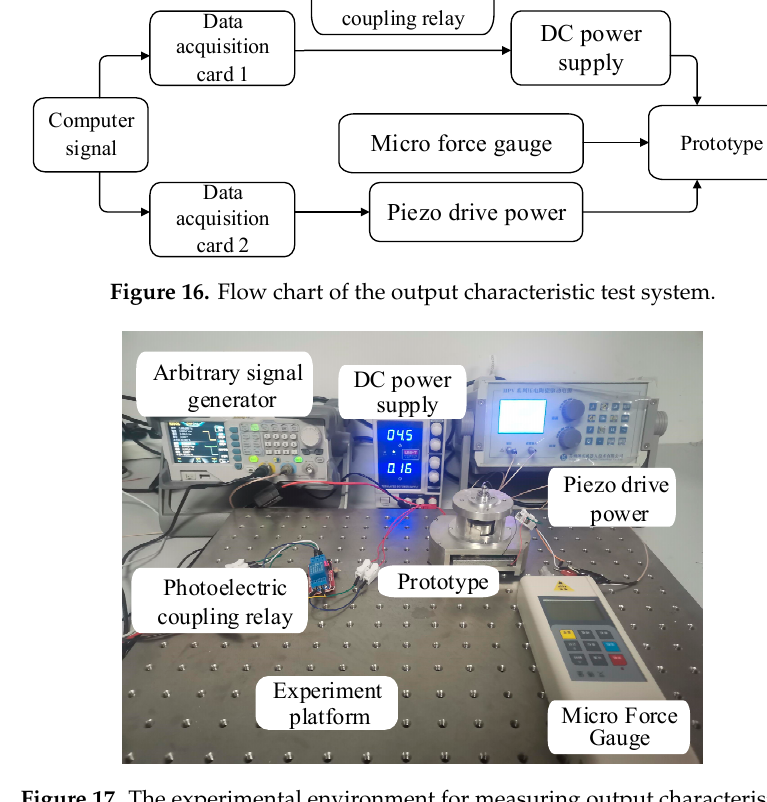
Figure 17. The experimental environment for measuring output characteristics.